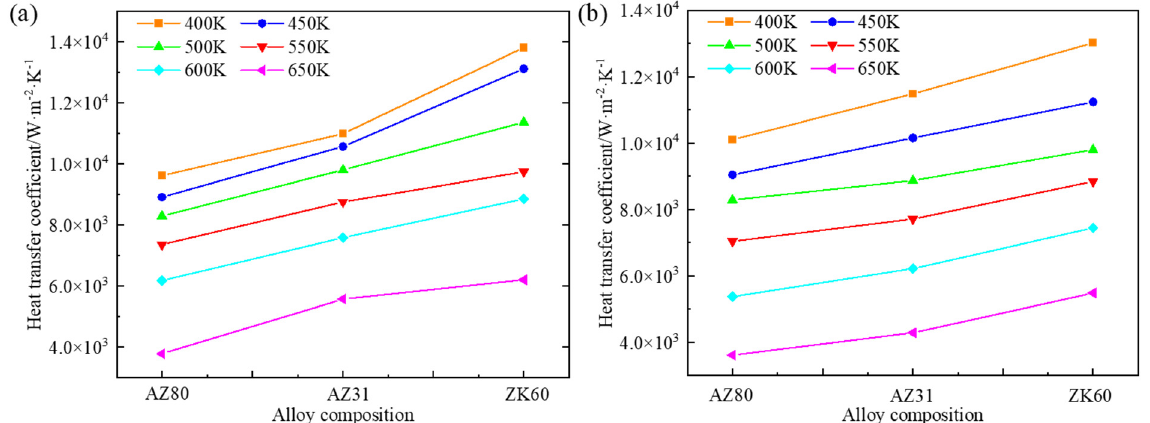
Figure 6. Effect of alloy type on HTC in the impingement zone ( a ) and the free-falling zone ( b ). In the impingement zone, the temperature at which the maximum value of the HTC occurs is about 400 K, and the HTC maximum values of ZK60, AZ31, and AZ80 are 13,899.6 W/(m 2 ·K), 11,212.3 W/(m 2 ·K), and 9626.6 W/(m 2 ·K), respectively. During the cool-